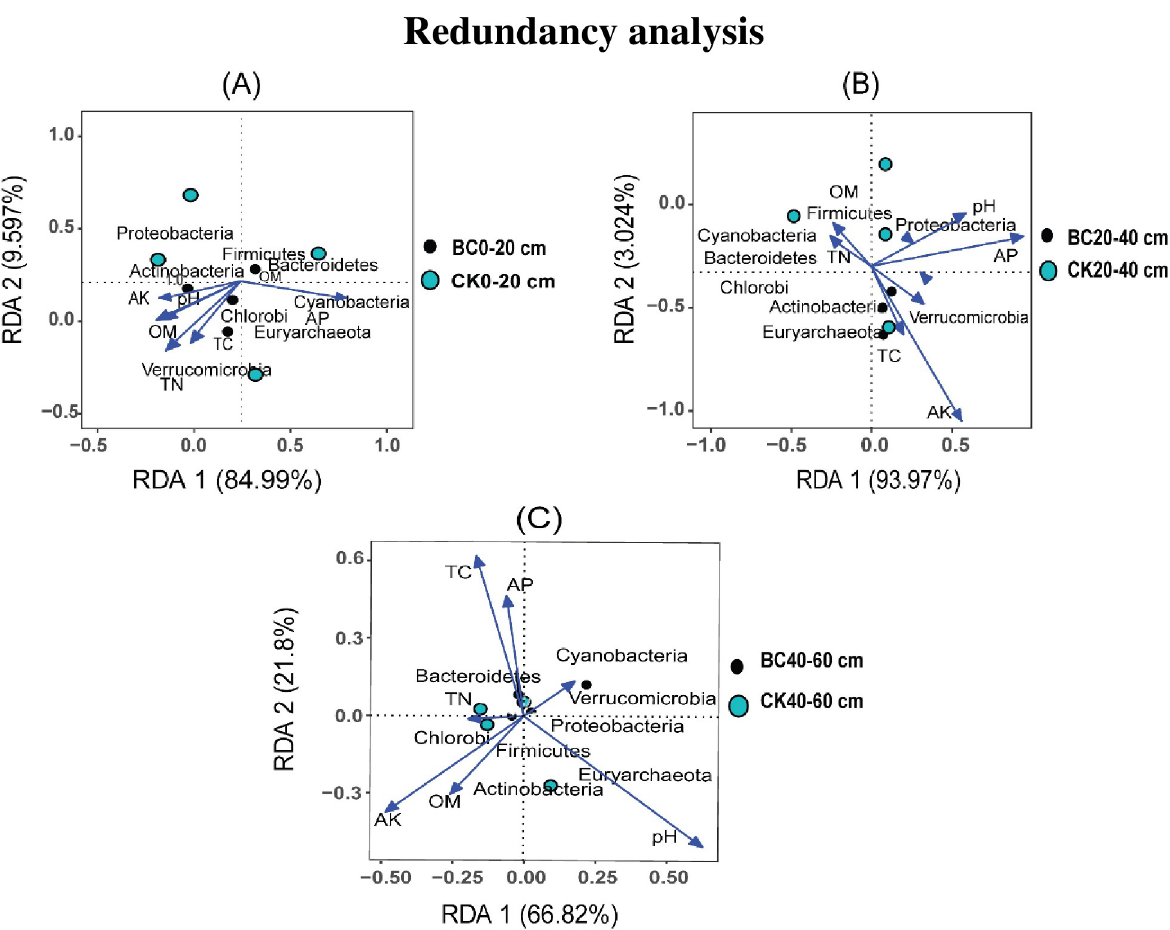
Fig 6. Redundancy analysis (RDA) of diazotrophic community composition and soil environmental variables. (A) diazotrophic phyla, (B) diazotrophic genera under and biochar amended soil and control in different soil depths.